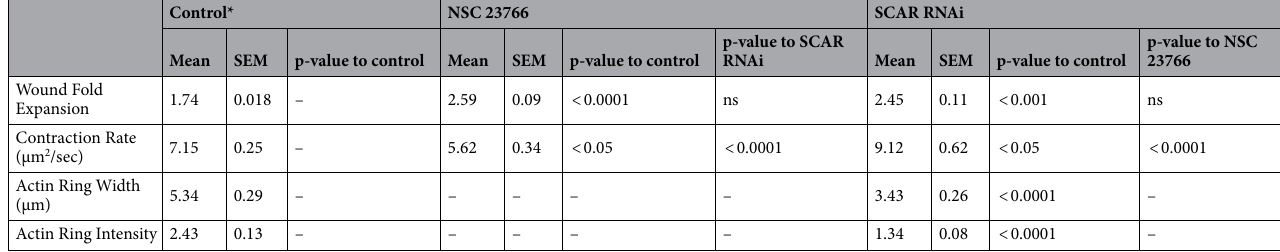
Table 3. Actin ring dynamics in the three genotypes shown in Fig. 3. *Control refers to vermillion (unrelated gene) knockdown. Statistical tests were performed using Kruskal–Wallis